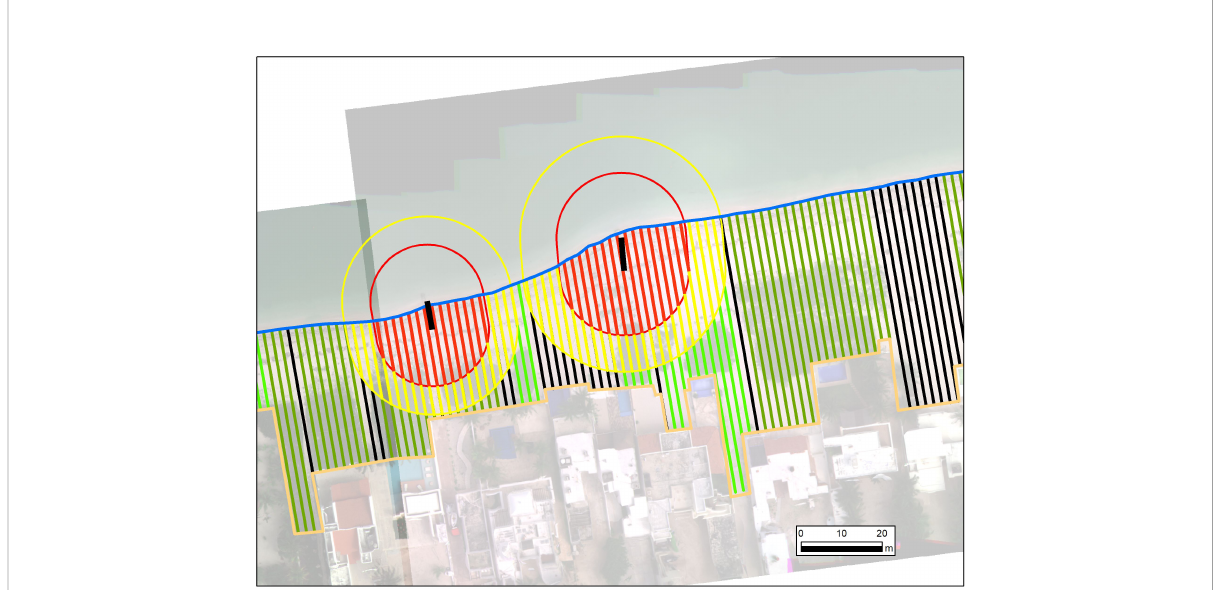
FIGURE 2 Example of the three selected indicators. The beach width indicator is the horizontal distance marked between the shoreline -blue line- and the fi rst infrastructure landward -orange line. The vegetation coverage indicator is marked for each transect in colors: black transect denotes absence of vegetation, light green transects denote partially vegetated transects and dark green transects denotes transects with a high vegetation coverage. The coastal infrastructure indicator is marked with red transects which are within the direct zone of in fl uence of the infrastructure, while the yellow transects are in the indirect zone of in fl